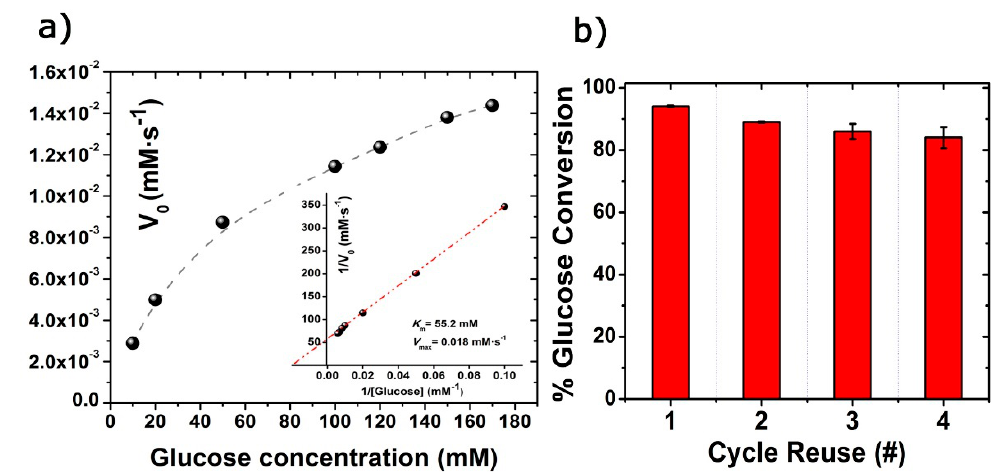
Figure 5. ( a ) Steady-state kinetic assay and evaluation of the conversion rates of glucose in the presence of the enzyme-like gold-silica nanocatalyst using different substrate concentrations (fixed concentrations of glucose: 10, 20, 50, 100, 120, 150, 180 mM). The formation of Fe-hydroxamate complex after 30 min was evaluated for each concentration to plot the apparent reaction rate ( V o ) and 1/ V o ; (inset: double-reciprocal plots of the glucose-oxidase mimicking activity of the nanocatalyst assuming a Lineweaver-Burk plot). Experimental details: [glucose] = 10–180 mM; [catalyst] = 0.025 mg/mL; pH = 7.4 in 0.2 M acetate/acetic buffer; temperature: 37 °C. ( b ) Reusability of the enzyme-like gold-silica nanocatalyst after 4 consecutive cycles. Experimental details: [glucose] = 150 mM; [catalyst] = 0.025 mg/mL; pH = 7.4 in 0.2 M acetate/acetic buffer; temperature: 37 °C; the nanocatalyst was recovered by centrifugation.